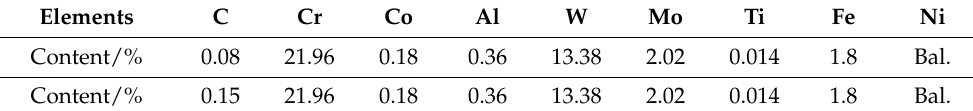
Table 1. The normal chemical compositions of the Haynes 230 and the CRHA.